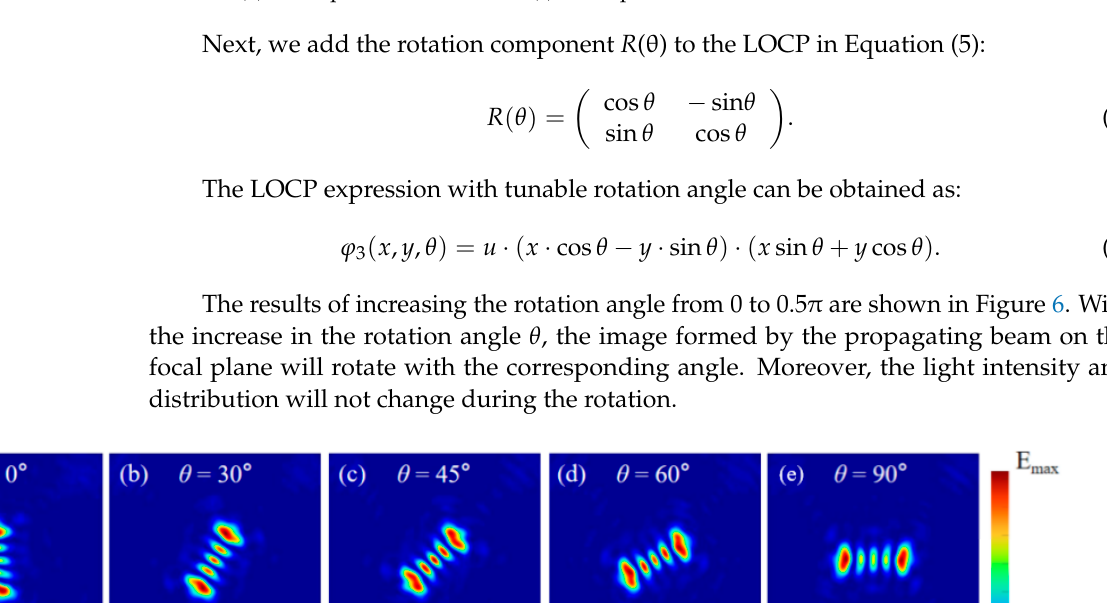
Figure 5. Optical field distribution of focused vortex beam based on LOCP under different TCs, where ( a ) corresponds to m = − 4, ( b ) corresponds to m = 0, ( c ) corresponds to m = 1, ( d ) corresponds to m = 2, ( e ) corresponds to m = 4, and ( f ) corresponds to m = 10.